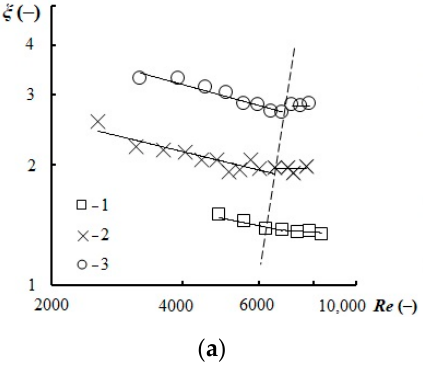
Figure 6. Dependence of the straight channel resistance coefficient (according to Table 1) on Reynolds number ( a ) and channel length ( b ). ( a ) Experimental points (1–3): 1—No. 4 at channel length l chan = 0.002 (m); 2—No. 5 at l chan = 0.007 (m); 3—No. 6 l chan = 0.022 (m); ( b ) Experimental points at channel width b = 0.005 (m) for the swirler channel profiles. Lines—calculation based on simulation results.